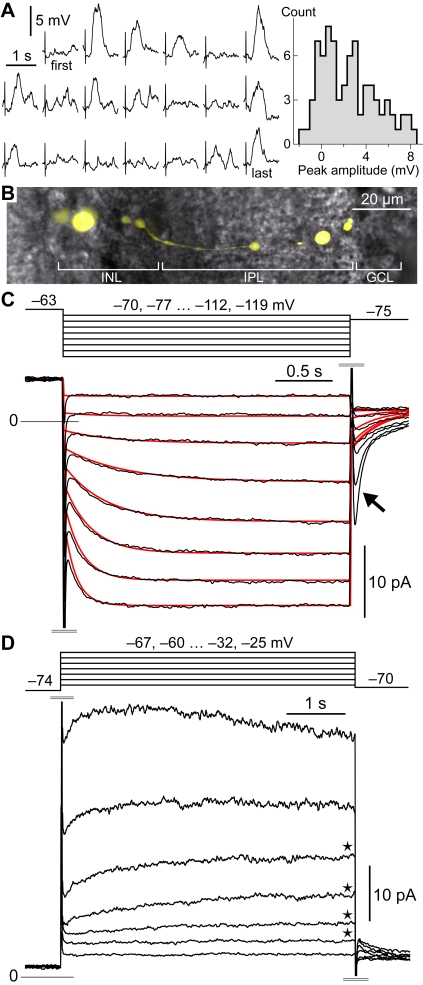
Individually recorded RBCs display an Ih–like current.A, Perforated–patch clamp recording in the retina slice of an RBC. Dim flashes of green light delivered at the cell's response threshold evoke highly variable depolarizing potentials in current–clamp (constant flash intensity, 6 ms flash duration, 4 s inter–flash interval, 20 consecutive episodes). Evidence for a quantal nature of these responses can be seen in the distribution of their peak amplitudes (histogram shows binned data from 79 flash episodes). B, The same RBC stained with LY at the end of the experiment. C, Voltage–clamp protocol applied to this RBC shows the progressive activation of a slow inward Ih–like current in response to increasingly hyperpolarizing voltage steps, from a holding potential of −63 mV (black traces). The model of eqs. 1–2 (red traces) provides a very good fit of the experimental records with parameters Gh = 0.144 nS, V0.5 = −89.5 mV, km = 5.0 mV, taumax = 510 ms; Gleak = 0.340 nS. D, In the same neuron, a voltage–clamp protocol of increasingly depolarizing steps from a holding potential of −74 mV, reveals an outward current with slow activation time course (traces with stars). At potentials above about −40 mV a larger current appears, with fast activation and slow inactivation kinetics. Experimental traces in C and D are averages of 11 and 10 trials, respectively. Stimulation artifacts are trimmed.